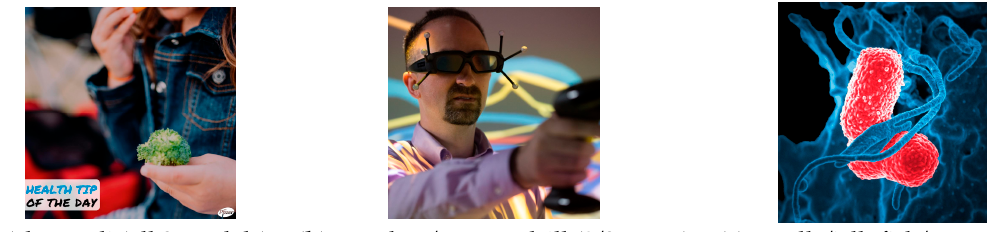
Figure 5. Examples of models’ predictions level of agreement.